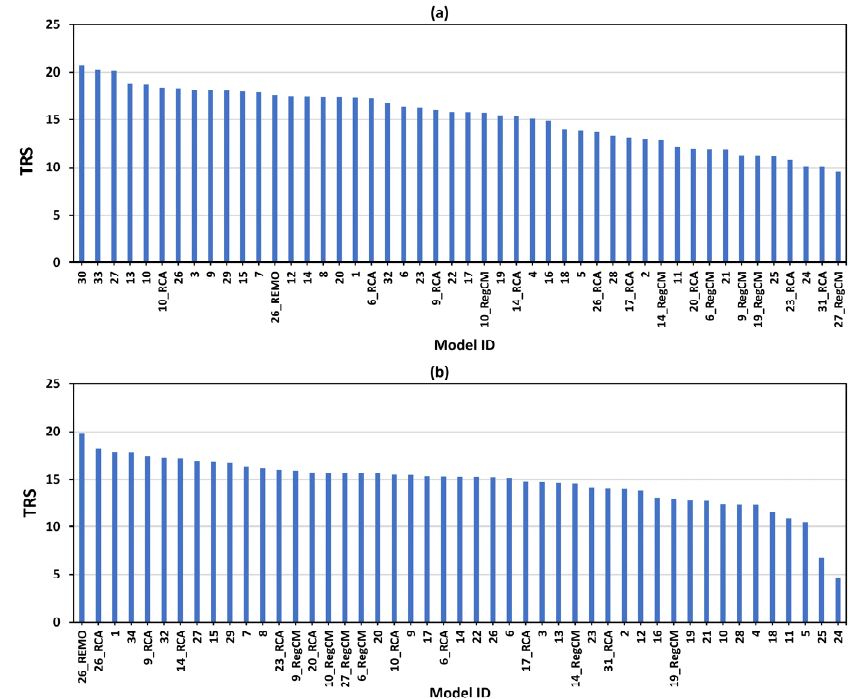
Figure 10. The estimated Total Relative Score (TRS) of all climate models along with best-performing models over ( a ) ocean, and ( b ) land of South Asian domain.